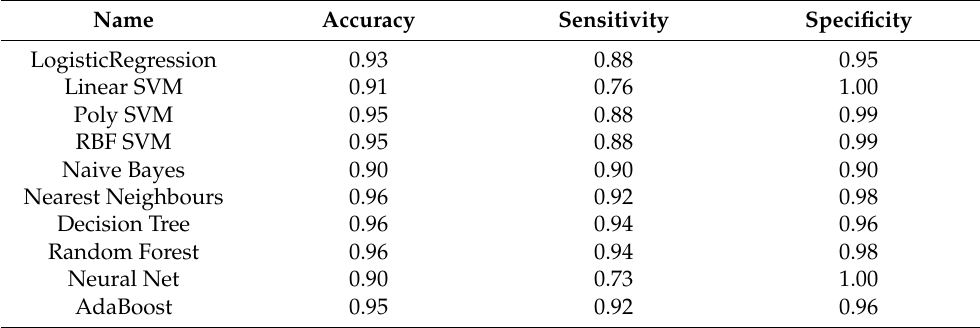
Table 5. Accuracy, sensitivity and specificity for TSNE and all tested combinations of the shallow learning